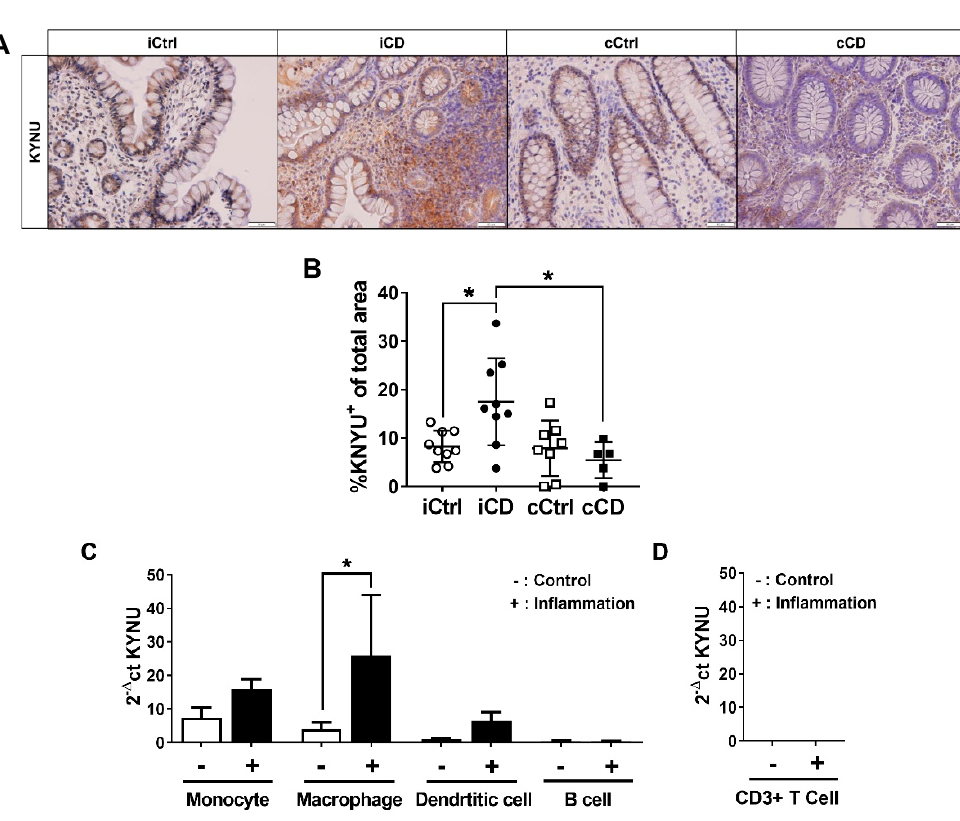
Figure 4. Di ff erential kynureninase (KYNU) expression in tissue samples of patients with ileal and colonicCD.( A )AnalysisofKYNUproteinexpressioninpara ffi n-embeddedtissueofCDpatientsviaIHC (representative images, magnification 20 × ). Inflamed tissue of patients with ileal and colonic CD were compared to noninflamed control samples from the respective bowel segments. Active inflammation was determined by the Riley score. ( B ) Di ff erential quantitative and localization-dependent evaluation of total KYNU + area in CD, compared to non-IBD control ( C , D ) Distribution and regulation of KYNU mRNA expression in ( C ) antigen-presenting cells and ( D ) CD3 + T cells (no signal detected). Antigen-presenting cells and CD3 + T cells were stimulated for 24 h with IFN γ (100 U / mL), TNF α (100 ng / mL) and IL-1 β (10 ng / mL). mRNA expression levels were determined by TaqMan real-time